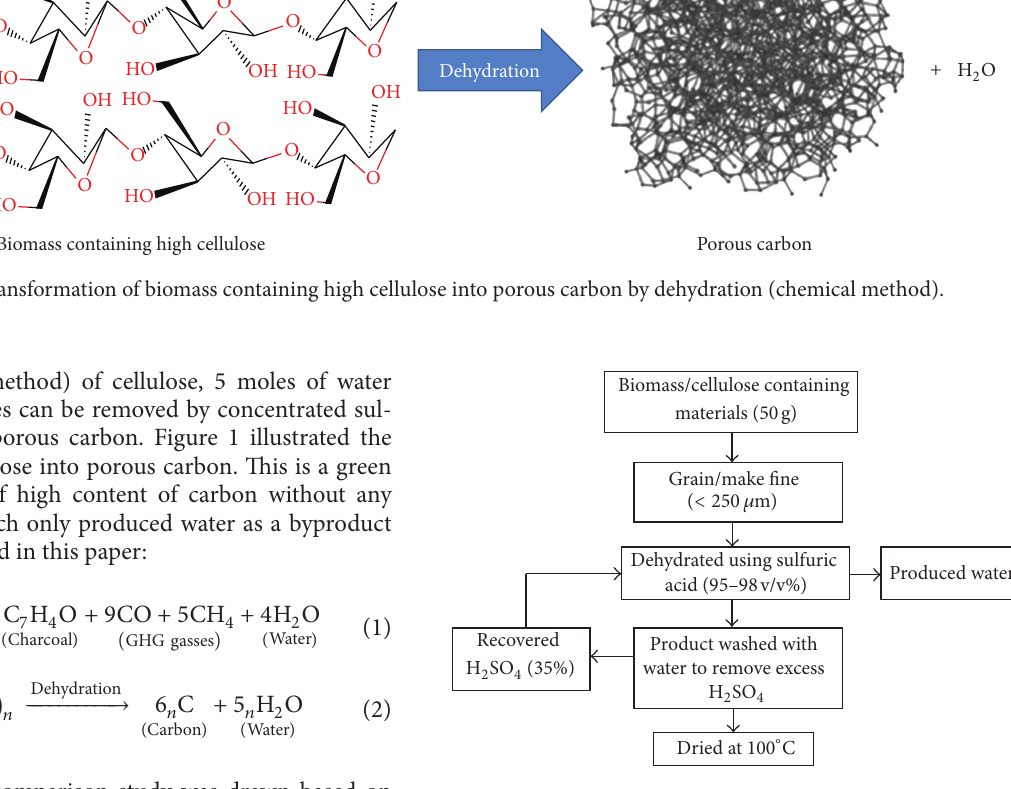
F 2: Flowchart for carbon production from high cellulose content